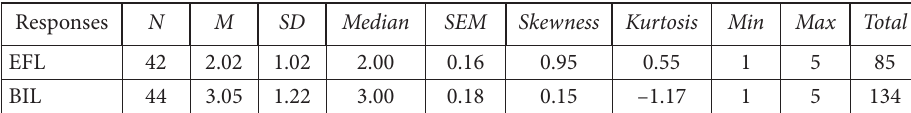
Table 4. Descriptive statistics of the scale items D – quality beyond age/grade level for English as foreign language (EFL) and bilingual (BIL) groups (source: created by authors)